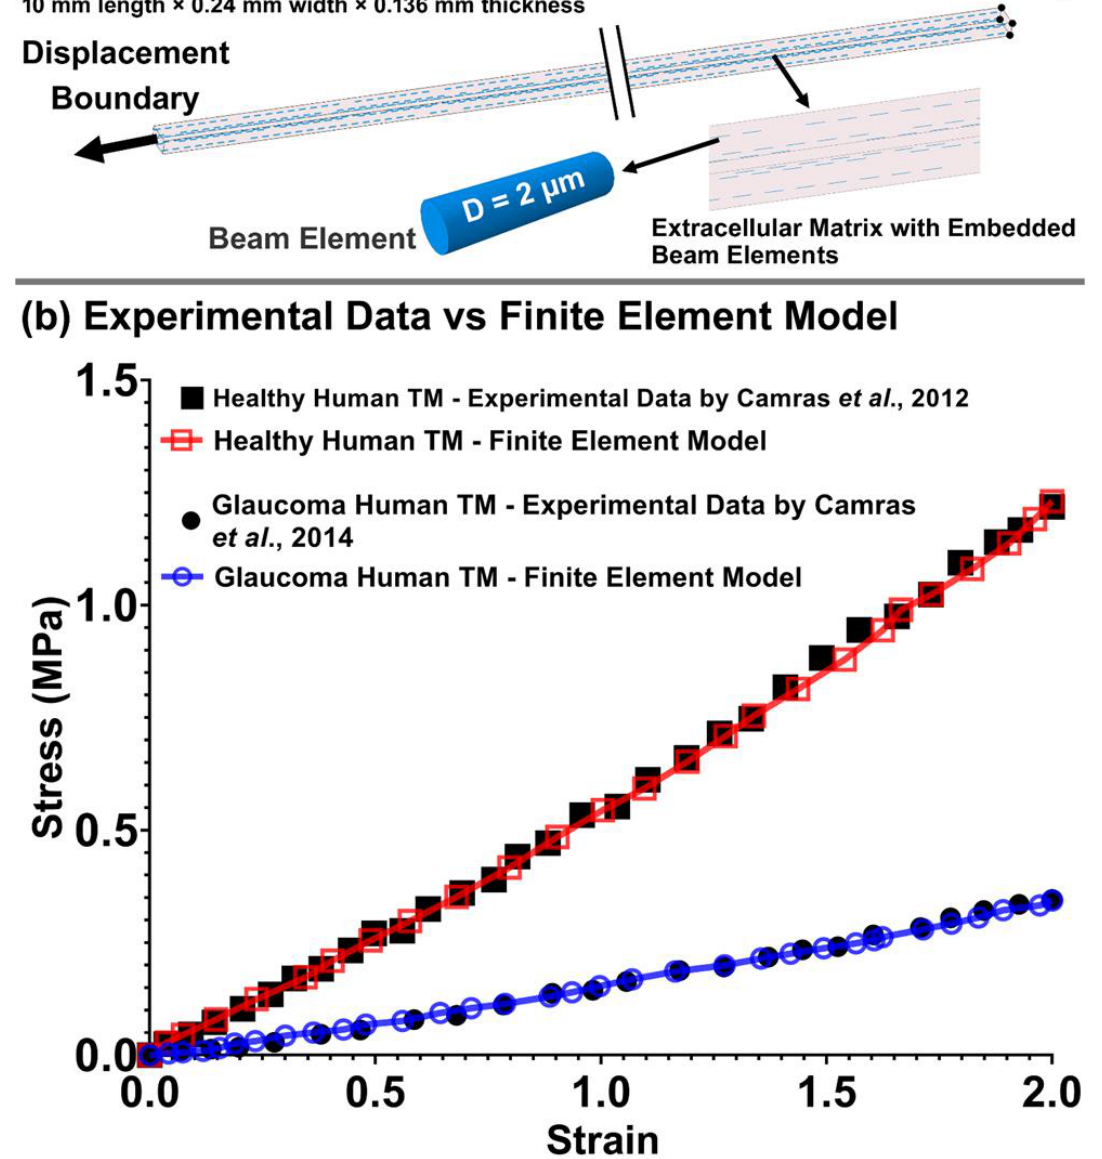
Figure 5. The ( a ) TM finite element model and ( b ) the experimental healthy and glaucoma human data versus the finite element models [91,92]. Table 1. Viscoelastic parameters for the healthy and glaucoma TM patch FE models. The ECM and beam elements were modeled as viscoelastic material.